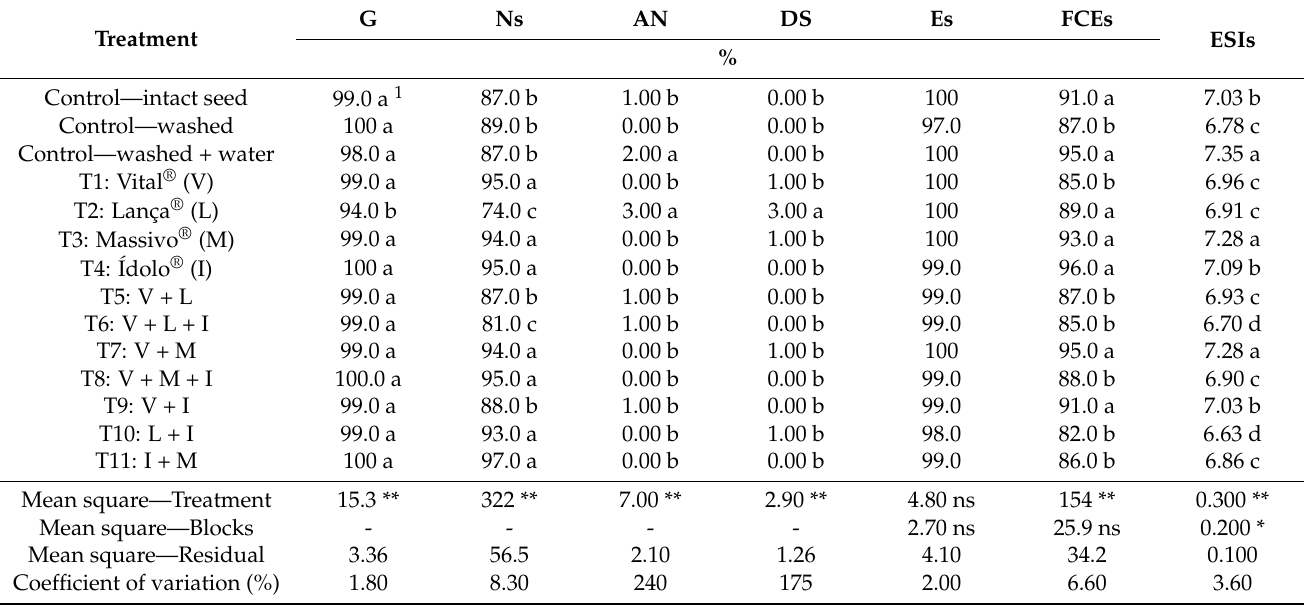
Table 4. Germination (G), strong normal seedlings (Ns), abnormal seedlings (AN), dead seeds (DS), seedling emergence in sand (Es), first count (FCEs), and seedling emergence speed index in sand (ESIs) of corn MG744 PWU from different seed treatments. Jata í , GO, Brazil, 2022.